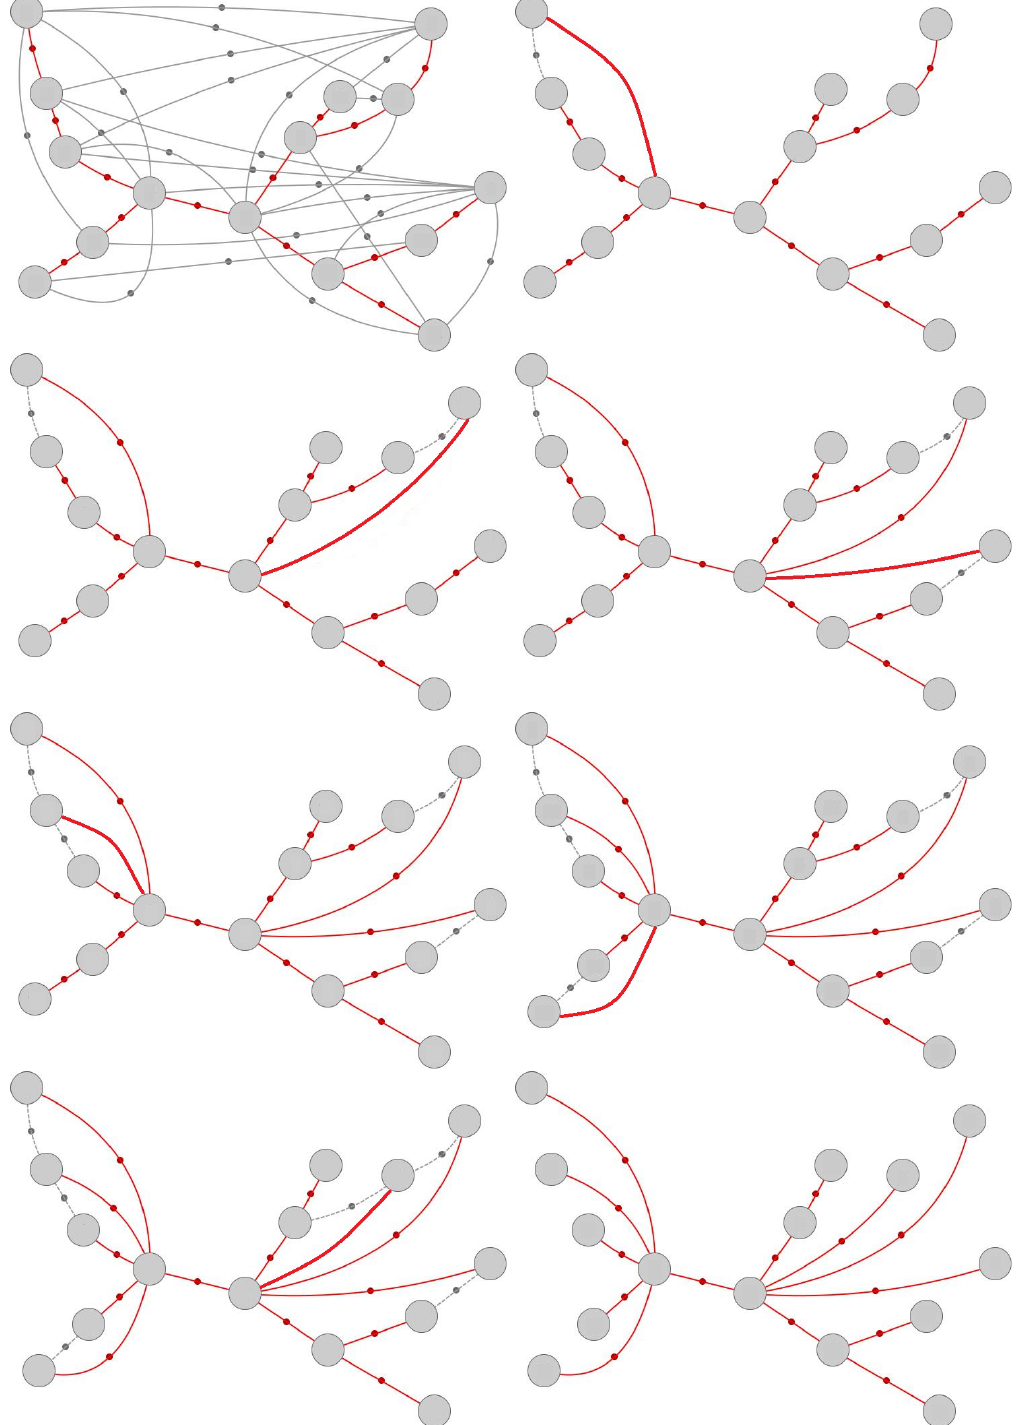
Figure 2: Step by step illustration of the algorithm